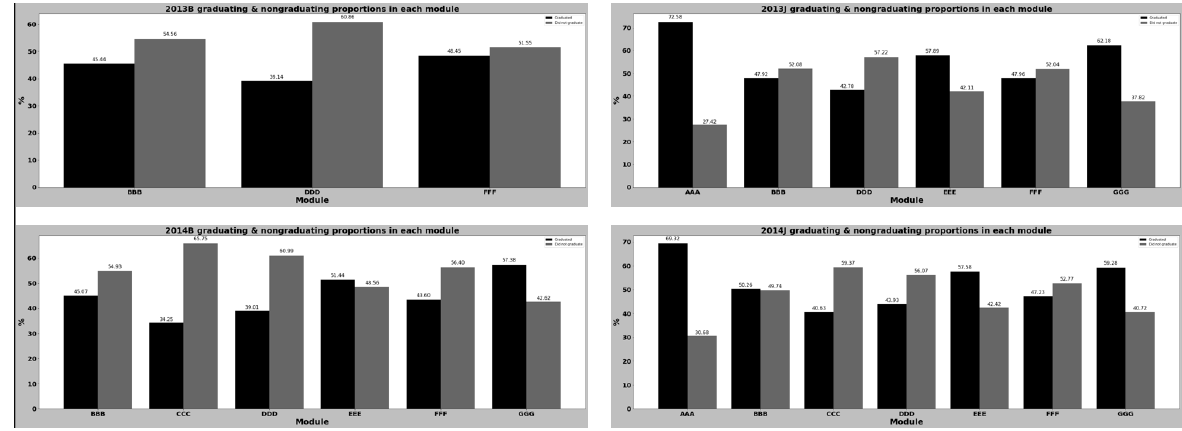
Graduating Versus Nongraduating Learners for Each Course in Each